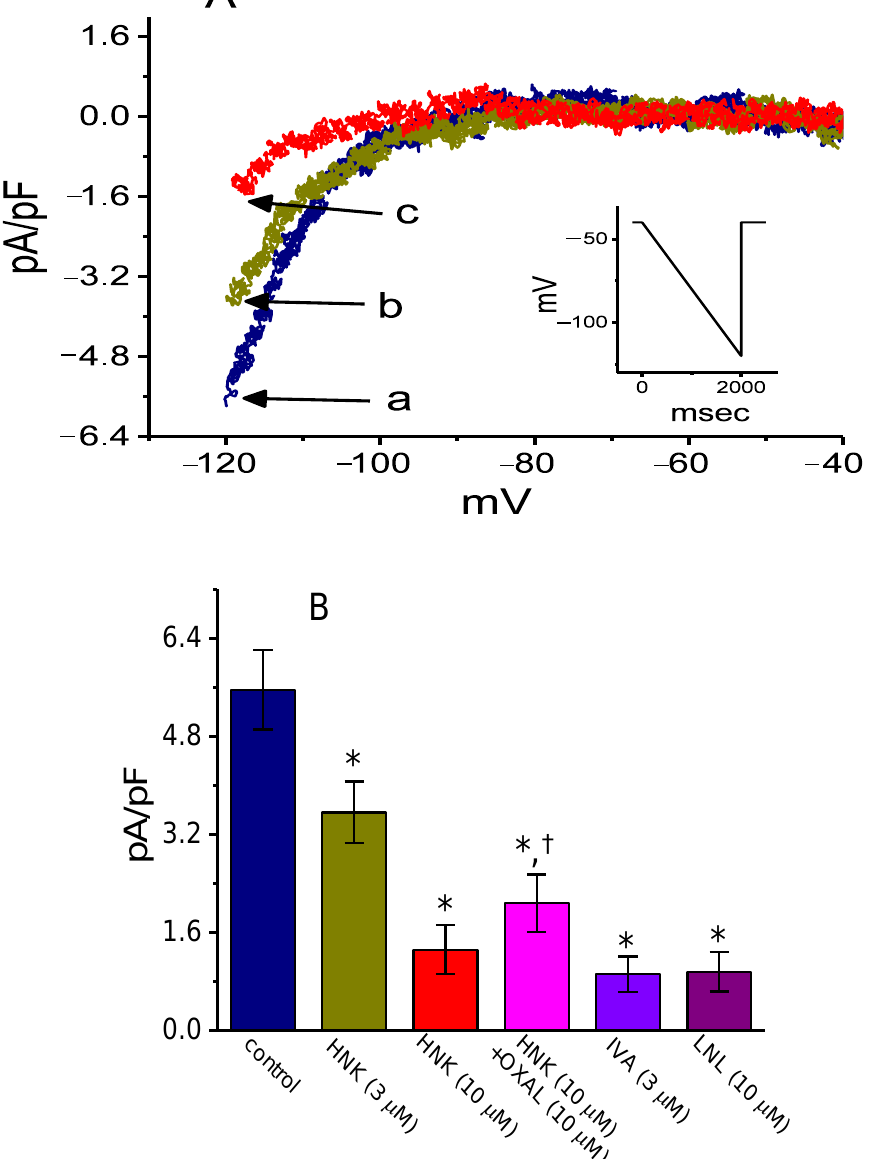
Figure 7. Effect of HNK on I h density elicited by a downsloping ramp pulse in Rolf 1B olfactory neurons. In this set of experiments, we voltage clamped the examined cells at −40 mV and applied the linear ramp pulse from −40 to −120 mV with a duration of 1 s (as indicated in the inset of ( A )). ( A ) Representative I h density elicited by such linear ramp taken from the absence or presence of HNK. Current density labeled a is control, and that labeled b or c was obtained 2 min after addition of 3 μM HNK or 10 μM HNK, respectively. ( B ) Summary bar graph depicting effect of HNK, HNK plus oxaliplatin (OXAL), ivabradine (IVA), or linalool (LNL) on I h density in response to ramp pulse. Current density was measured at the level of −120 mV. Each bar indicates the mean ± SEM ( n = 8). * Significantly different from control ( p < 0.05) and † significantly different from HNK (10 μM) alone group ( p < 0.05).